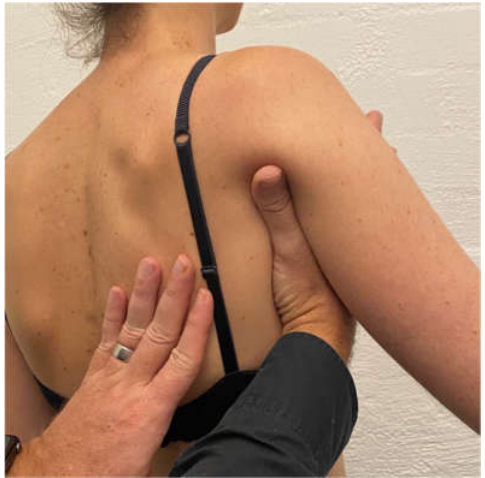
Figure 1. Manual correction of the scapula into upward rotation.